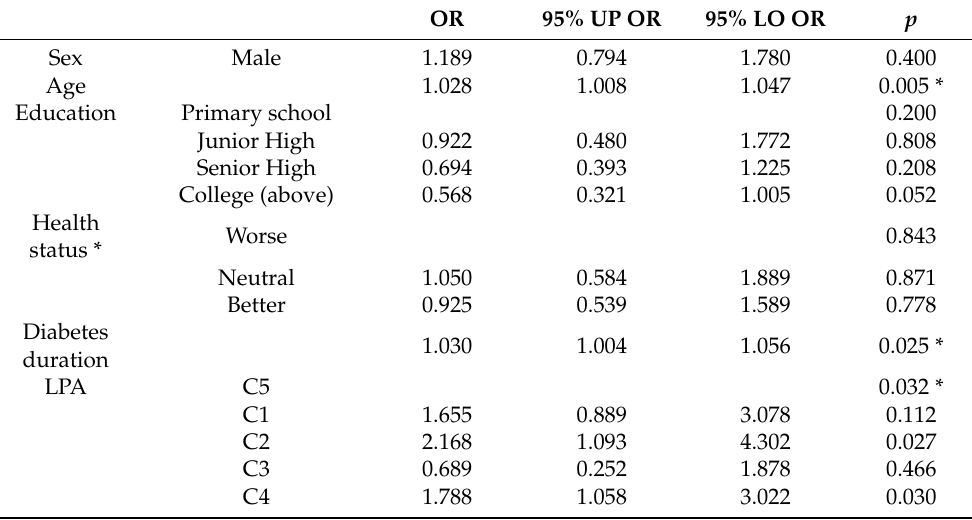
Table 3. The likelihood of diabetic retinopathy event from multivariable logistic regression model. OR 95% UP OR 95% LO OR